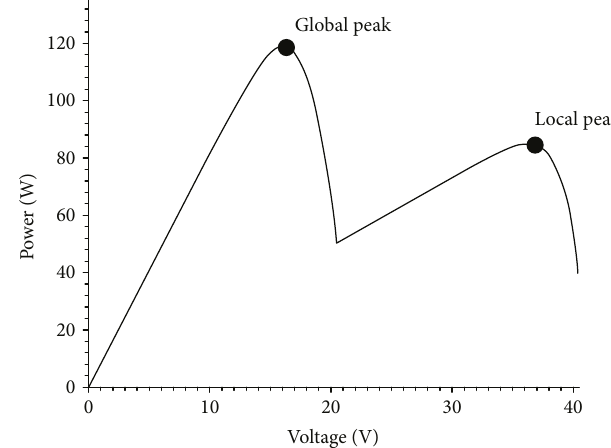
Figure 2: Characteristic curves of PV under partial